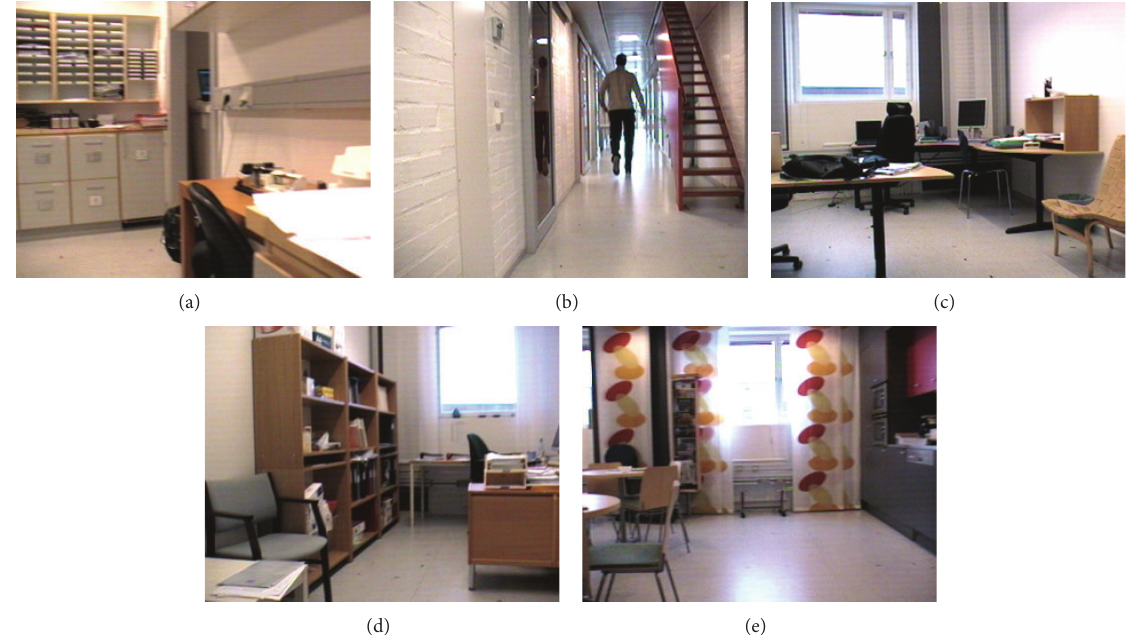
Figure 4: IDOL2 dataset sample images: (a) Printer Area, (b) Corridor, (c) Two-Person Office, (d) One-Person Office, and (e)